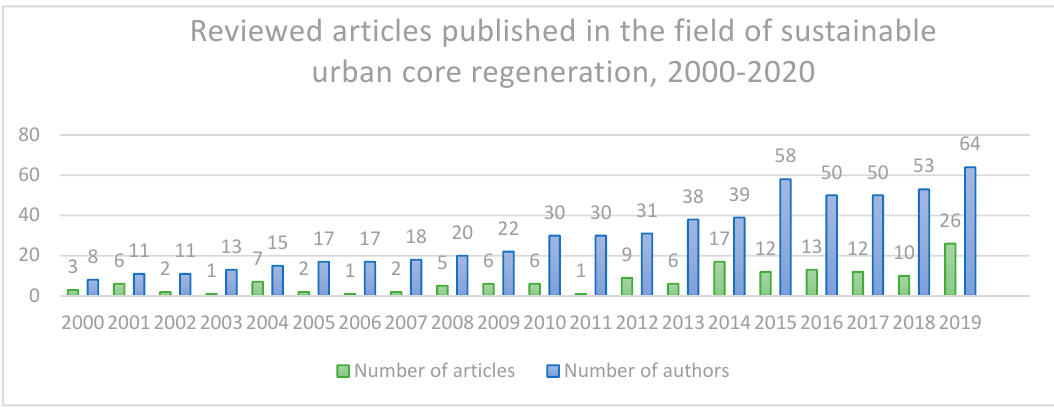
Figure 2. Growth trend of published articles and authors between 2000 and 2019 in scientific journals.